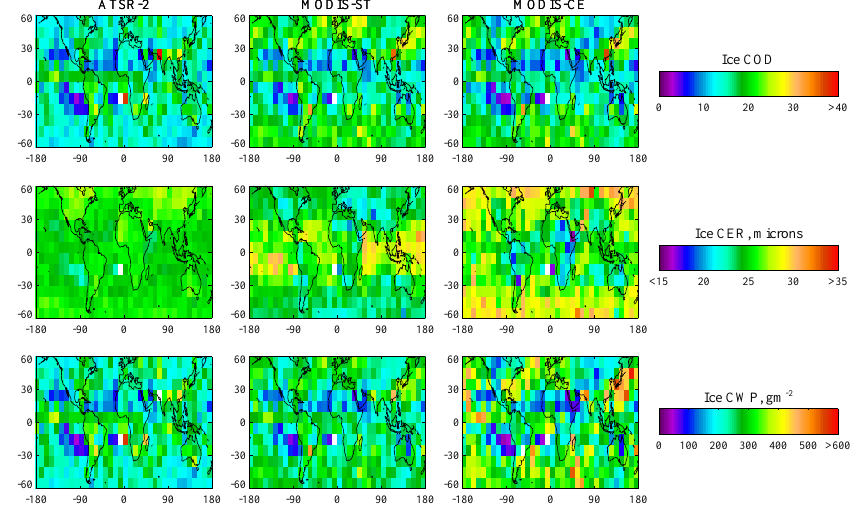
Fig. 14. As Fig. 13, except for ice clouds.